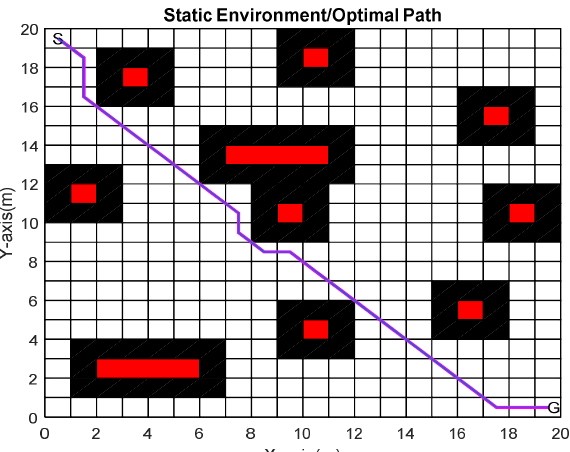
Fig. 12. Best Path found by Standard ACO for Experiment 2